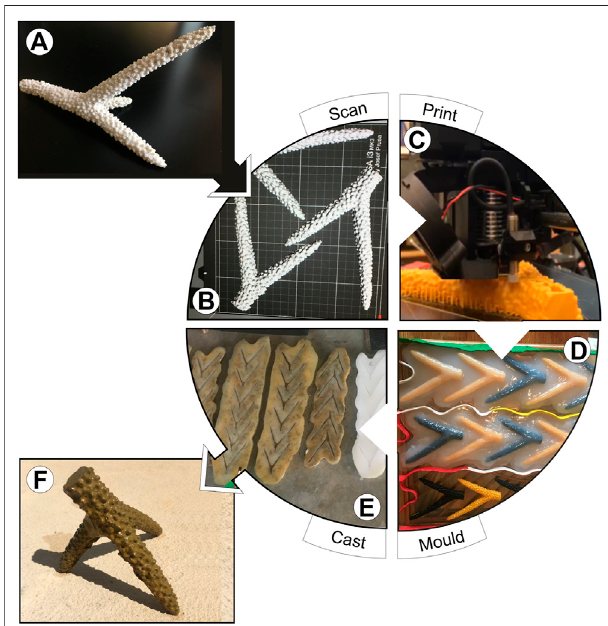
FIGURE3|(A) Fragment ofthefocal biogenic habitat-forming organism is selected for 3D-scanning; here a coral skeleton fragment of Acropora cervicornis (staghorn coral) with a fl at, Y-shape branch. (B) 3D fi le created by scanning the fragment from Figure 3A , which can be manipulated furthertoalter/agumentstructuralfeaturesandcomplexity. (C) Multiplecopies of the 3D fi le are printed using PLA fi lament and extrusion printers. (D) Consecutive layers of silicone mould material are poured over duplicated 3D prints; plaster casings (not shown) are made for each silicone mould to enhance the mould ’ s structural stability (E) The resulting silicone moulds are fl ippedoversotheresultingcavityisfacingupwards,linedwithvegetableoilto act as a mould release and then fi lled with desired casting material. In this fi gure,pigmentedconcretehasbeenstuffedintothefoursiliconemoldsonthe leftsideoftheimage(wherethemouldsappeardarkgrey)andthetwosilicone moulds on the right side of the image are empty and have not yet been fi lled with concrete (where the moulds appear white). (F) Concrete casts are assembled into fi nal, more complex arti fi cial habitat modules; here a tri-pod shaped arti fi cial coral for deployment in clusters in a fi eld experiment (see Figure 5